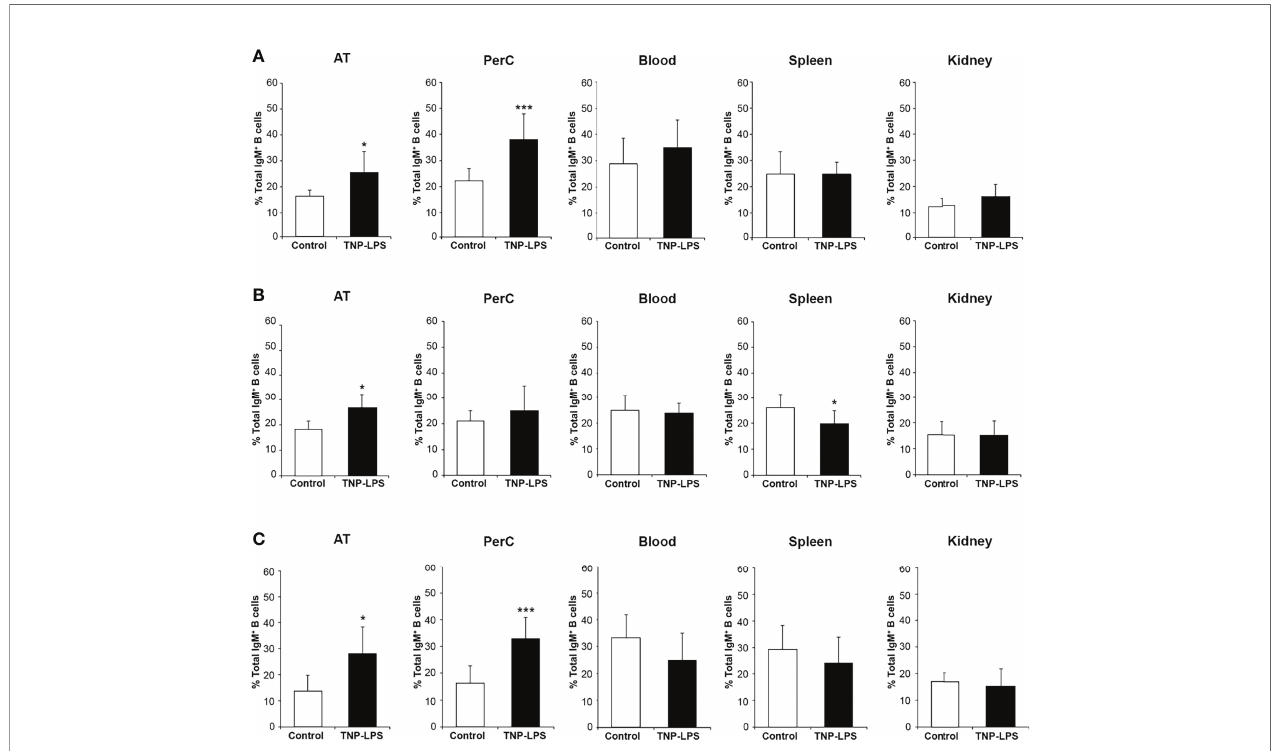
FIGURE 6 | Percentage of total IgM + B cells after the intraperitoneal immunization of rainbow trout with TNP-LPS. Rainbow trout were immunized intraperitoneally with TNP-LPS or mock-immunized (control) and leukocytes isolated at different times post-immunization from AT, peritoneal cavity (PerC), blood, spleen and head kidney (HK). Leukocytes were then incubated with an anti-trout IgM mAb conjugated to PE and analyzed by fl ow cytometry. Graphs shown the mean percentage of the total IgM + B cells in each tissue at days 7 (A) , 14 (B) and 28 (C) post-immunization (mean + SD; n = 8). Asterisks denote signi fi cantly different values between the TNP-LPS immunized group and the control group (*p ≤ 0.05 and ***p ≤ 0.005). See Figure S2 , where representative dot plots showing the percentage of total IgM + B cells (IgM vs FSC) are included for each group and tissue at the three sampling